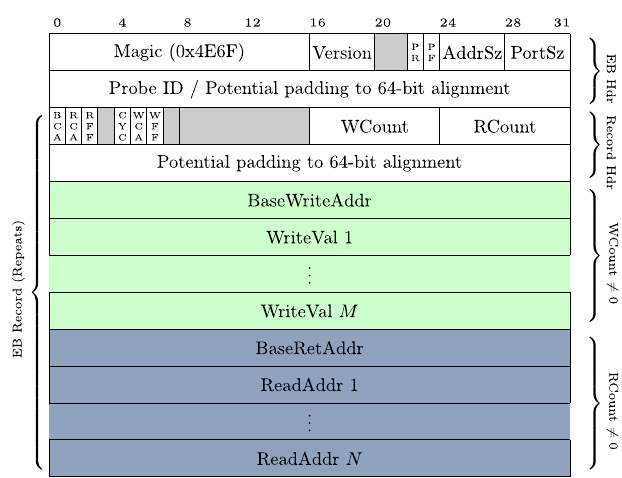
FIG. 9. EB packet structure, featuring an 8B header followed by EB records containing WB bus operations.